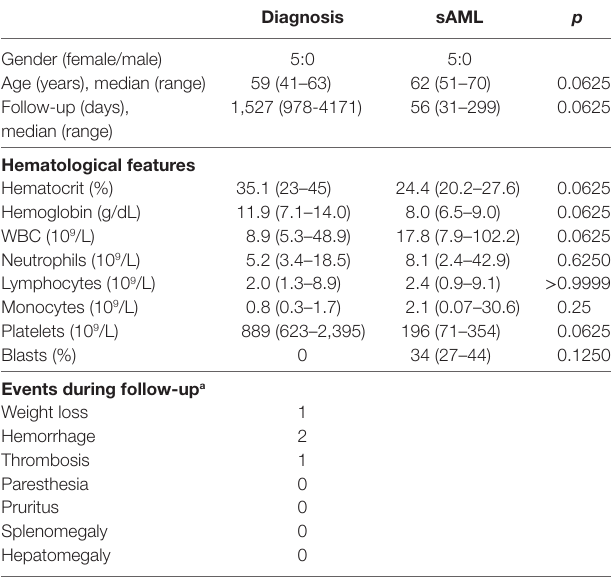
Table 1 | Clinical and laboratorial features of patients who progressed to sAML.